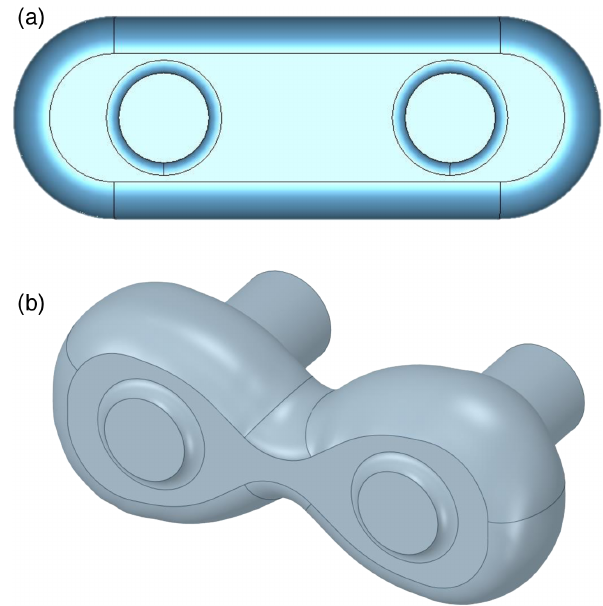
FIG. 5. 3D illustrations of the original racetrack coupling bridge: (a) front view and (b) view of the modified coupling